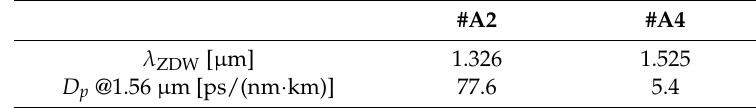
Table 5. Measured ZDWs and dispersion values at intended pump wavelength for the fibers #A2 and #A4.